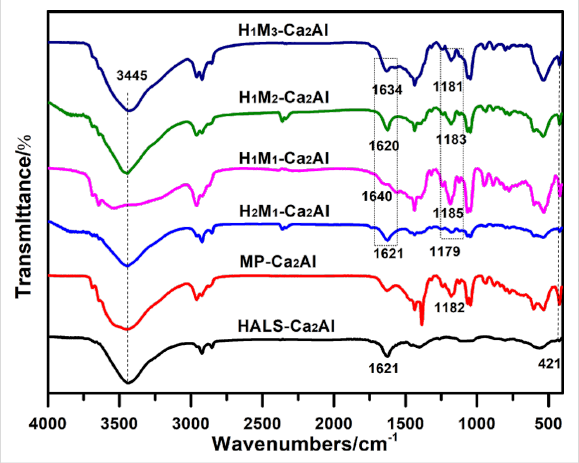
Figure 3: FTIR spectra of different H n M n ′ -Ca 2 Al-LDH samples.